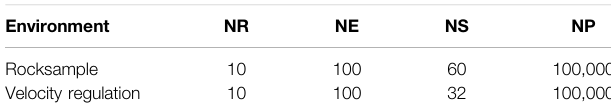
TABLE 4 | Parameters of tests on